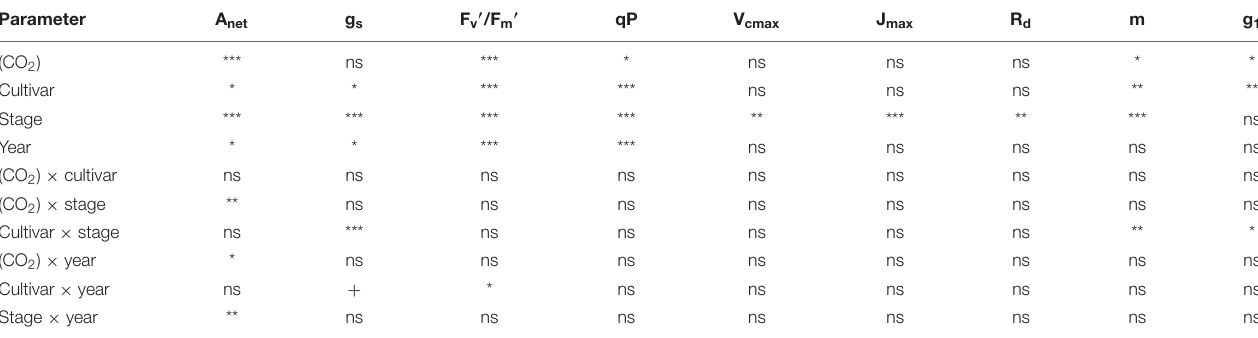
TABLE 1 | The analysis of variance (ANOVA) of photosynthetic characteristics and model parameters. Parameter